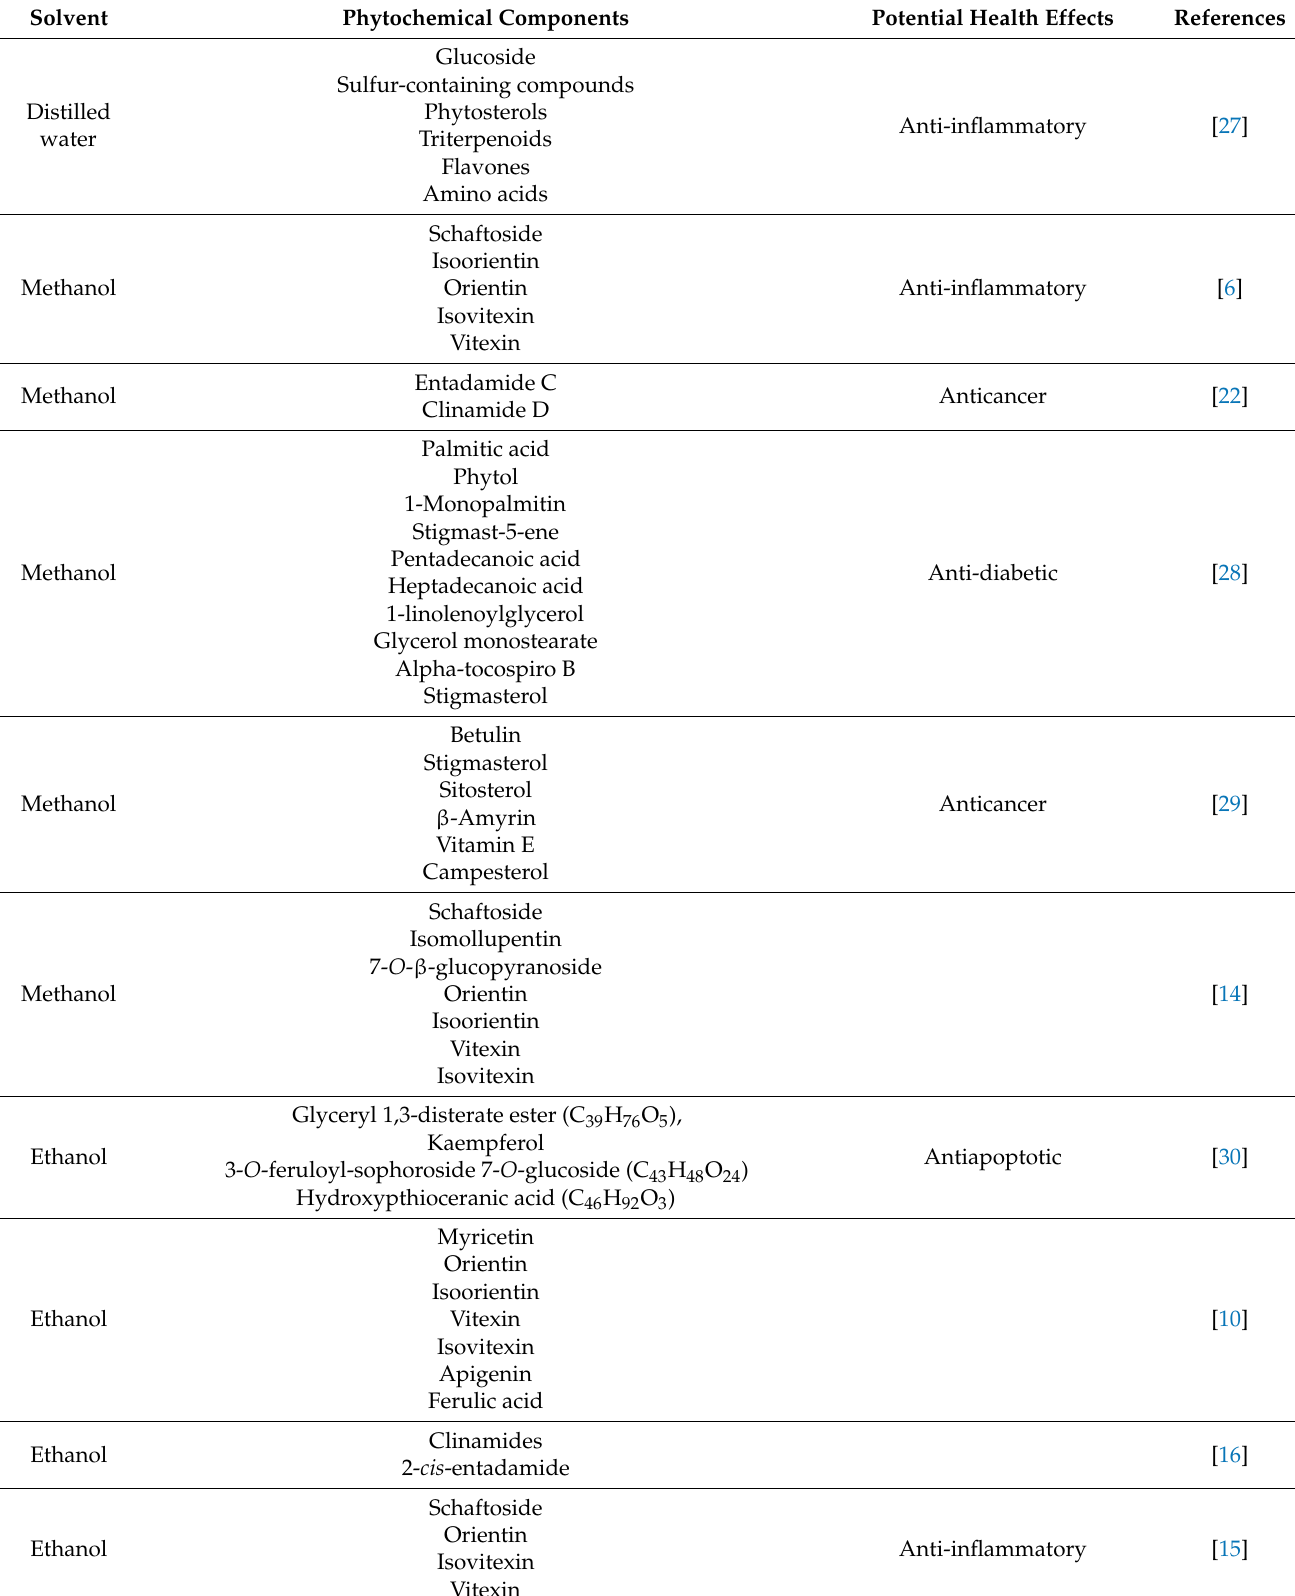
Table 1. Solvents used in extraction and phytochemicals obtained from C. nutans